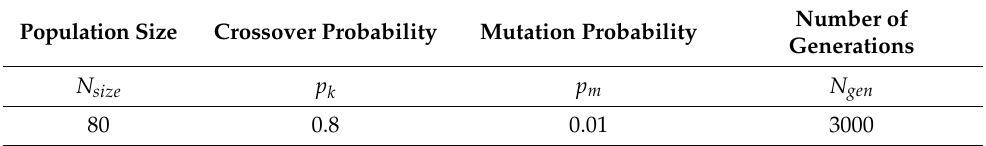
Table 6. Genetic algorithm parameters.